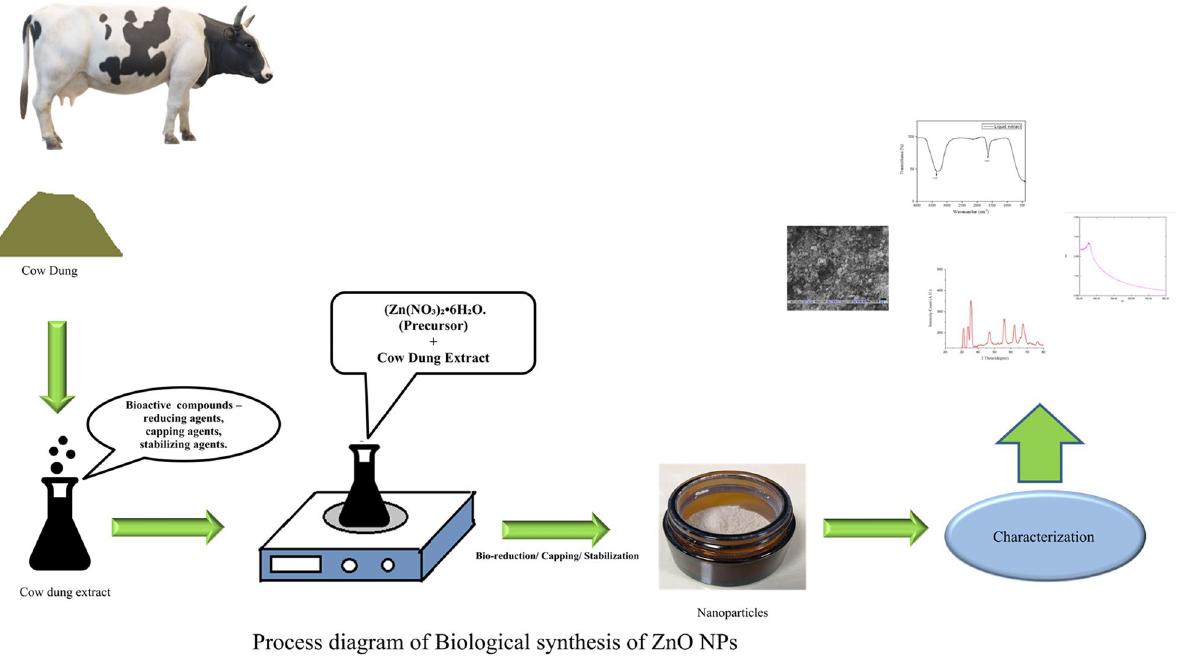
Figure 1. Synthesis of ZnO nanoparticles from cow dung